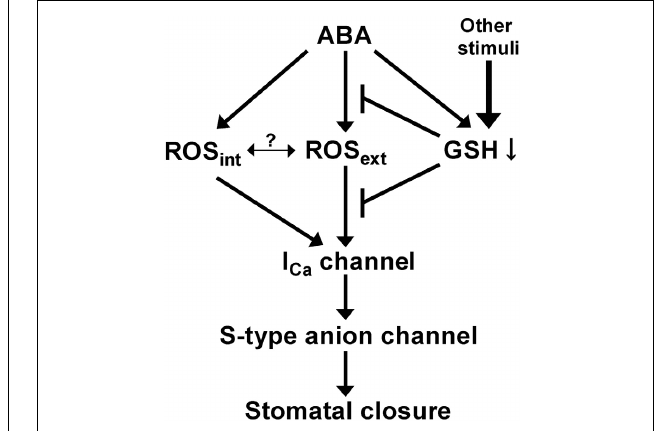
FIGURE 6 | A simplified model of GSH regulation of guard cell ABA